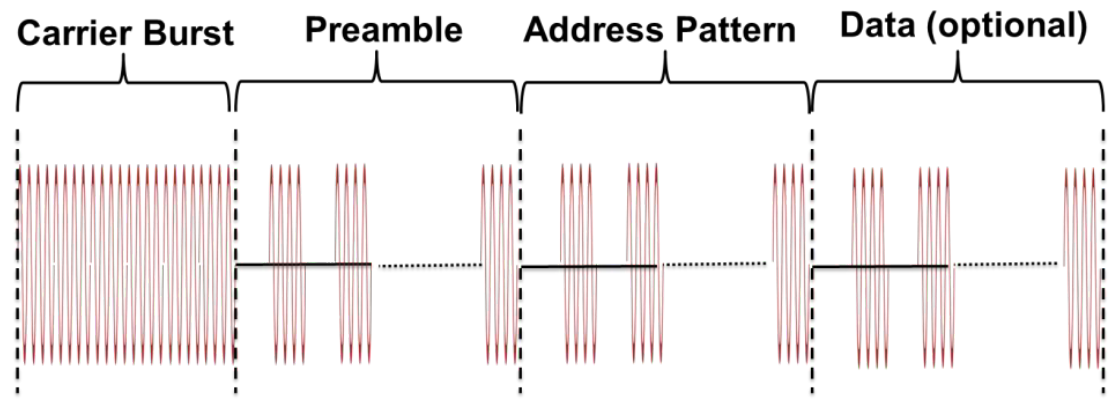
Figure 6. WuC format as in the AS3932 datasheet